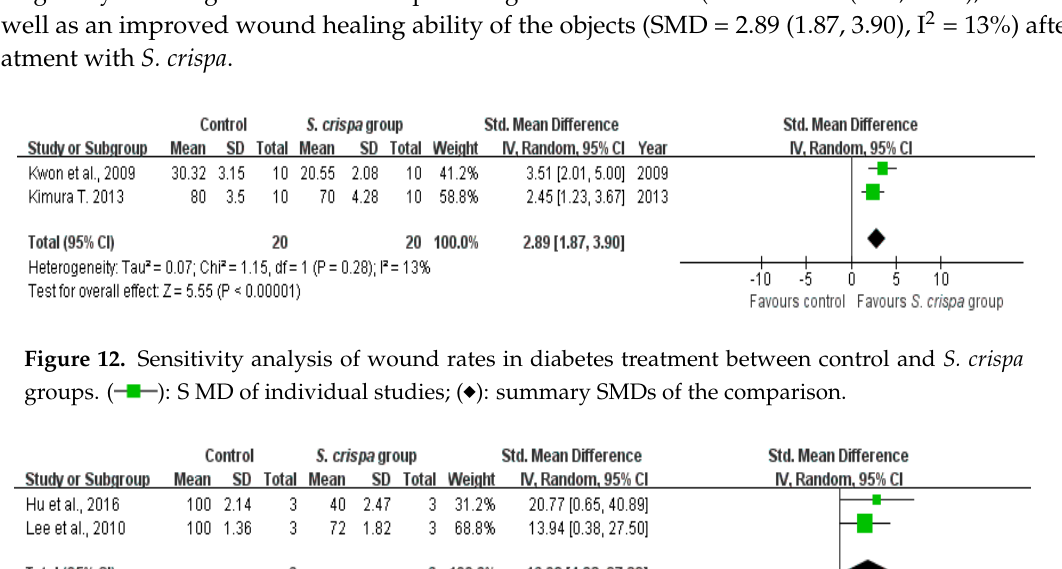
Figure 6. Comparison of the IFN- γ production potential between control and S. crispa groups. ( ): SMD of individual studies; (  ): summary SMDs of the comparison.